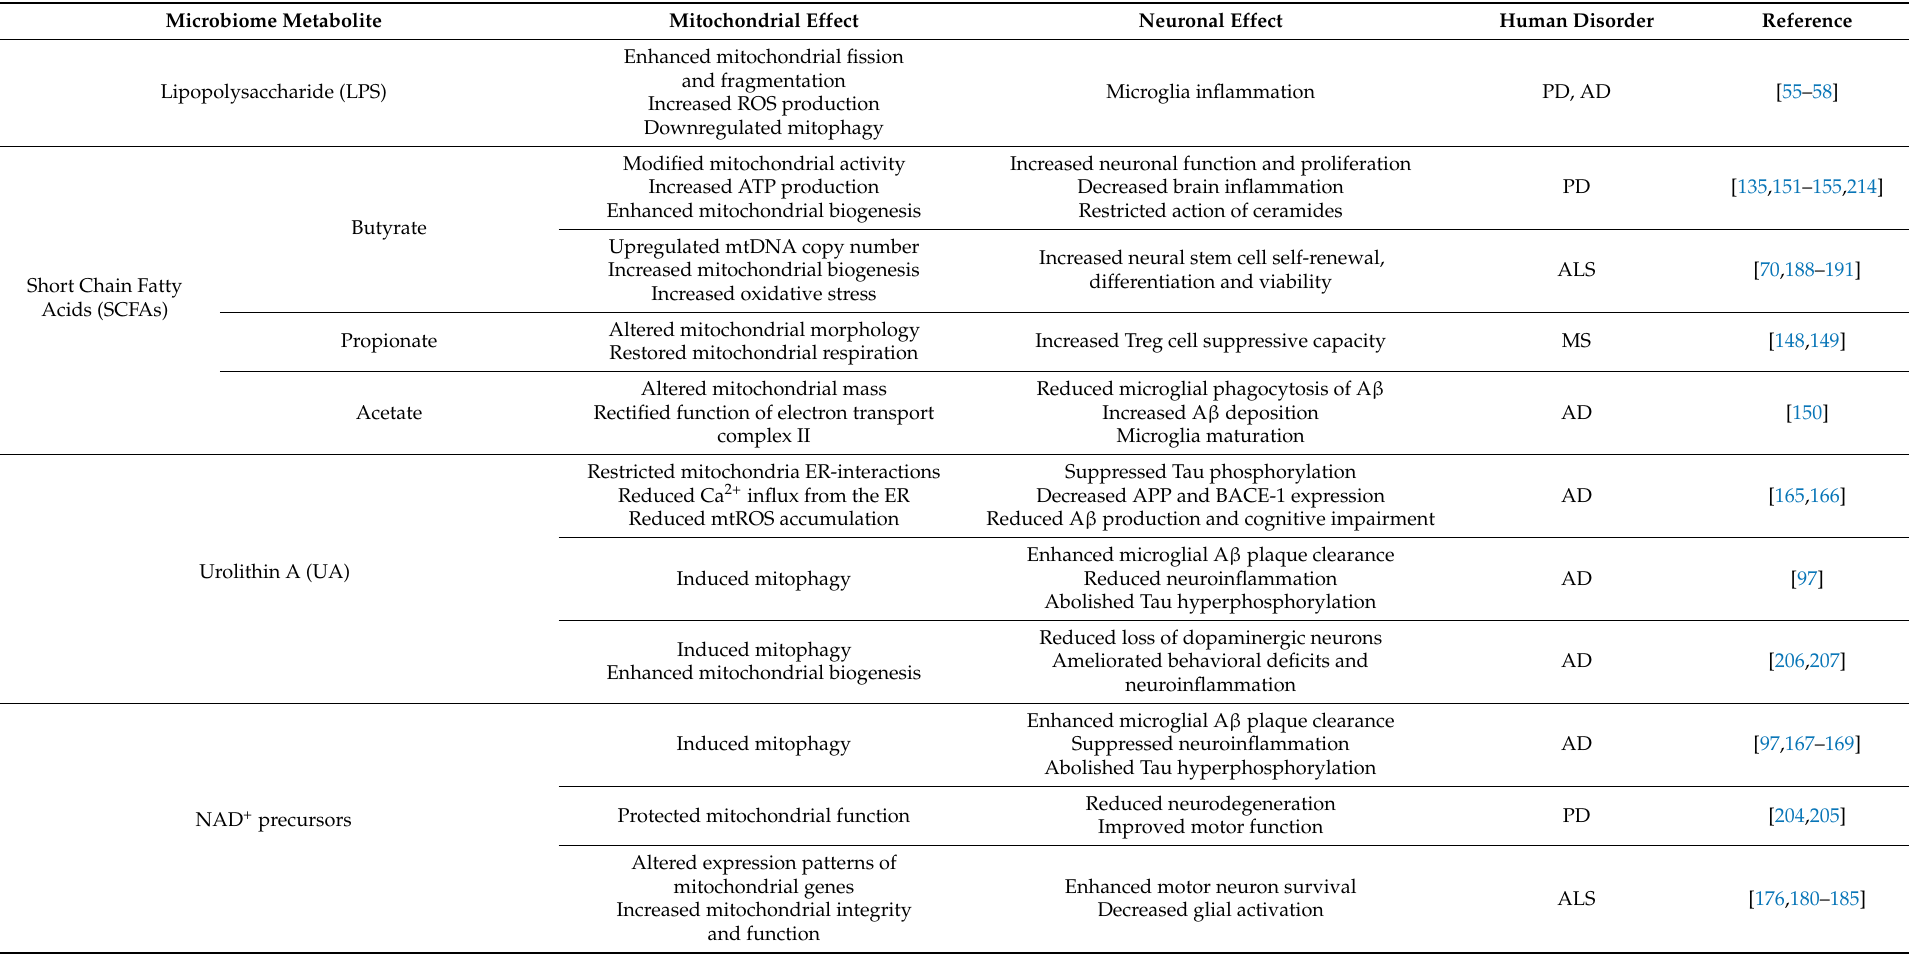
Table 1. Summary of mitochondria-affecting microbiome metabolites involved in neurodegenerative